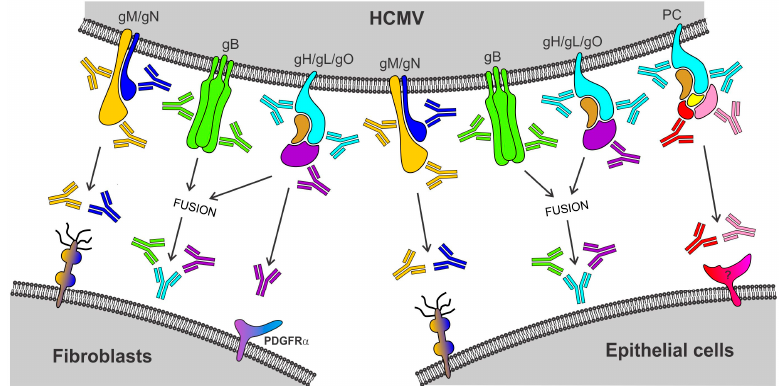
Figure 1. Model for Human cytomegalovirus (HCMV) entry and antibody-mediated neutralization. While HCMV entry into both fibroblasts (FB) and epithelial cells (EC) depends on envelope